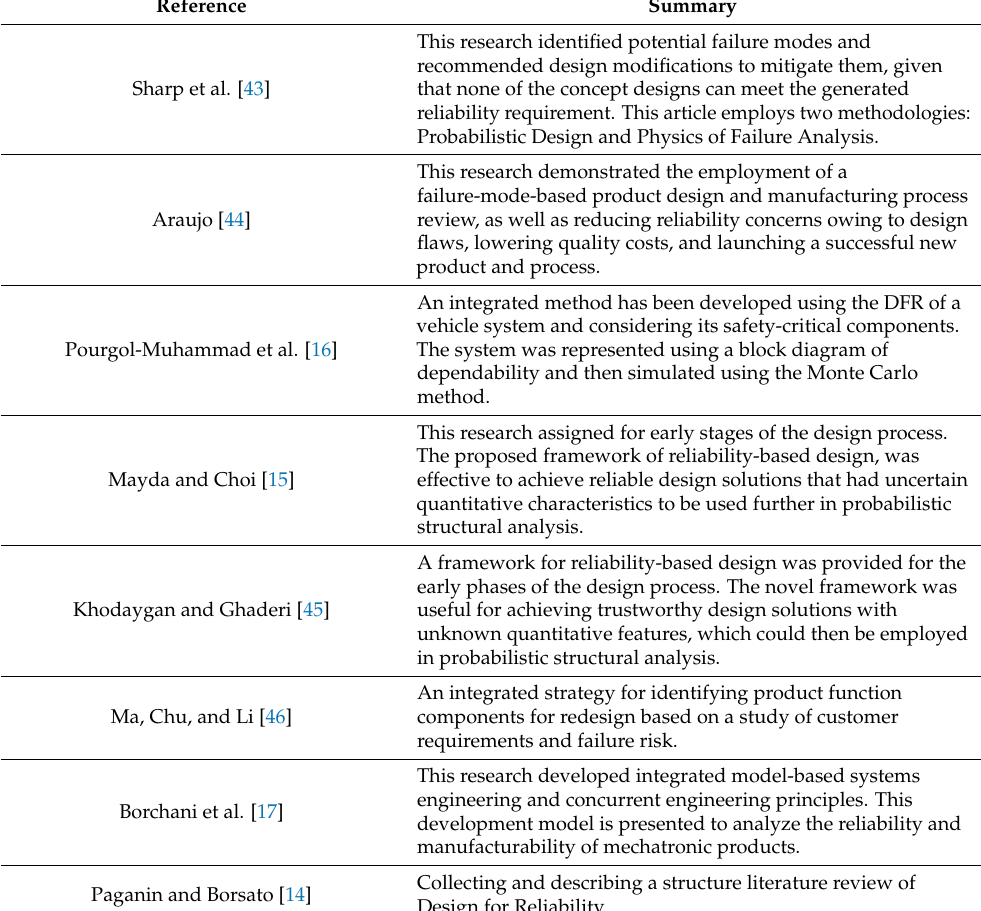
Table 2. Summary of studies in the DFR